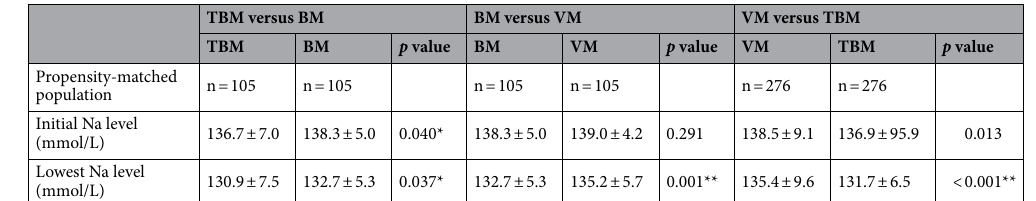
Table 2. Comparison of initial and lowest serum sodium levels in propensity-matched populations with tuberculous, viral, and bacterial meningitis. BM, bacterial meningitis; TBM, tuberculous meningitis; VM, viral meningitis. All scores are shown as percent, n value, or mean (SD). The propensity score was matched 1:1 between the two comparison groups controlling for age, sex, cerebrospinal fluid (CSF) white blood cell count, CSF glucose, and CSF protein. The analyses were performed with the independent t-test. * p < 0.05, ** p <